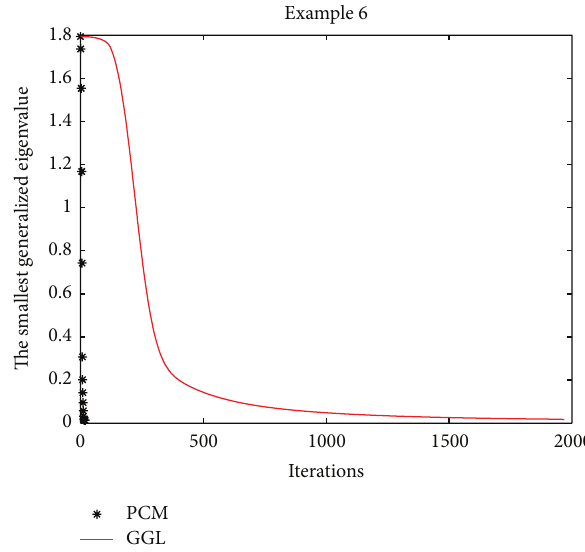
Figure 2: Numerical results of Example 6 with PCM and GGL